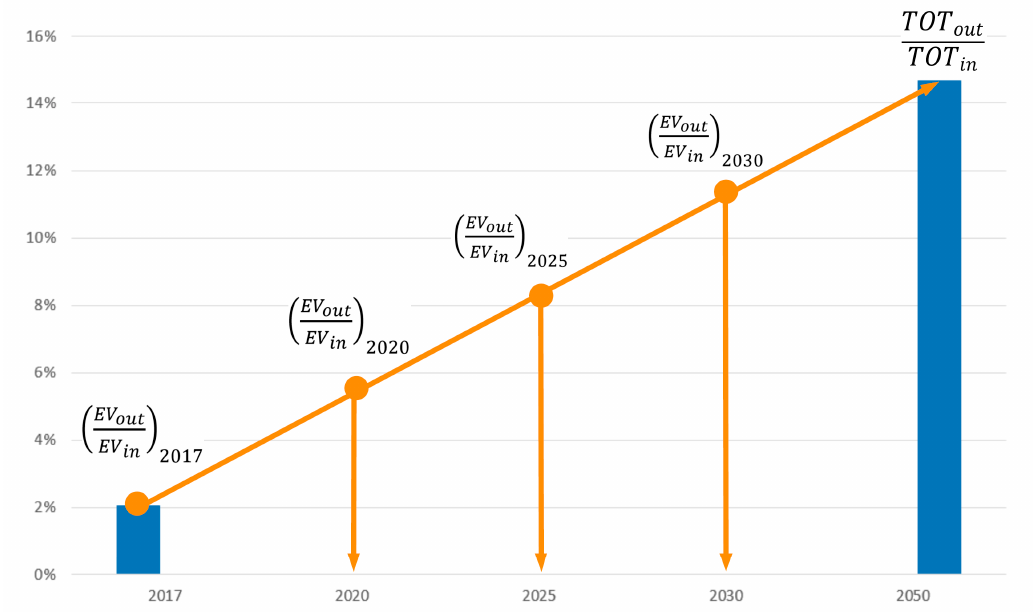
Figure 2. Scaling down process for the collected xEV fleet size forecast values.